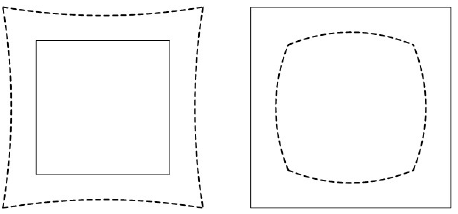
Figure 6: Radial direction and tangential direction distortion of